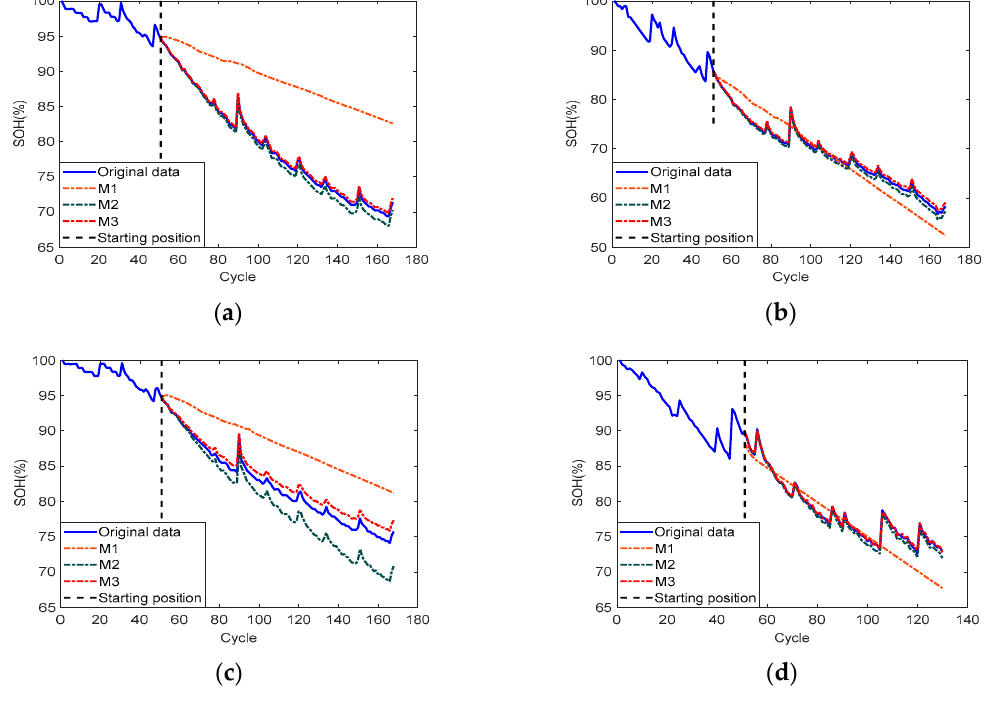
Figure 5. Prediction results of comparative experiments: ( a ) battery No. 5; ( b ) battery No. 6; ( c ) battery No. 7; ( d ) battery No. 18.